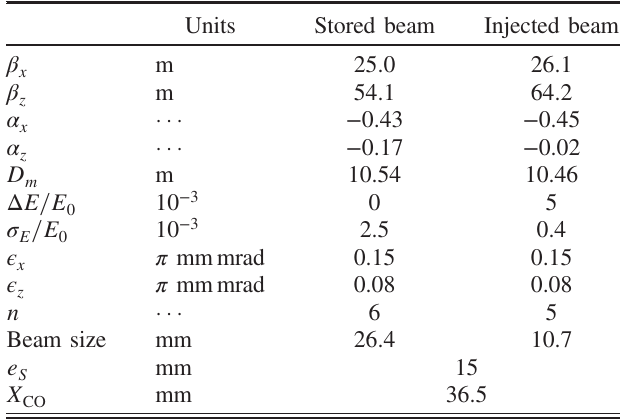
TABLE X. Optical parameters at the injection